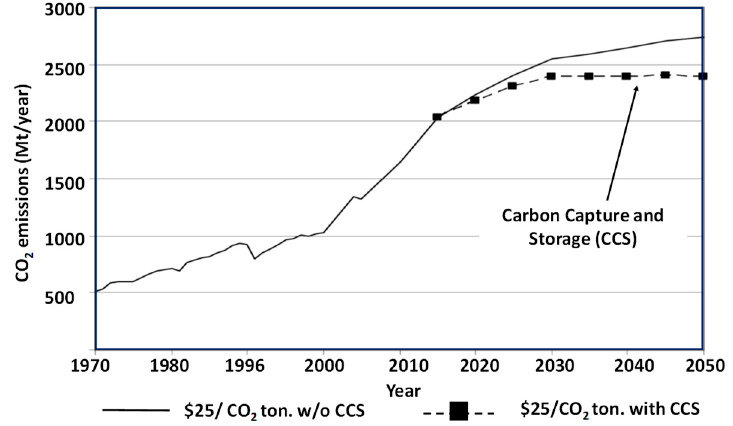
Figure 8. Direct CO 2 emissions due to cement production (1970–2050) [9].